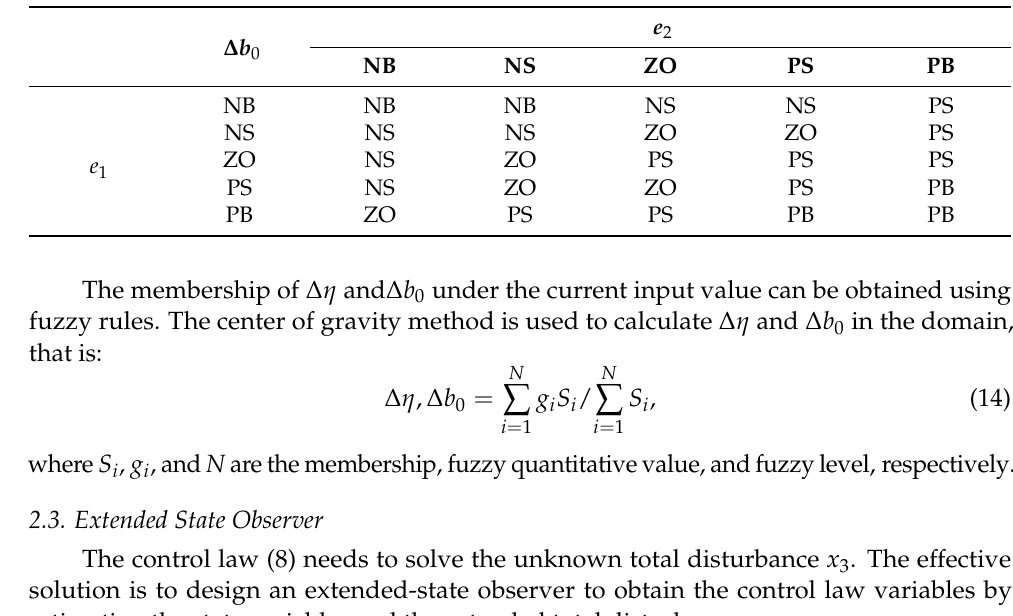
Table 2. Fuzzy rules of ∆ b 0